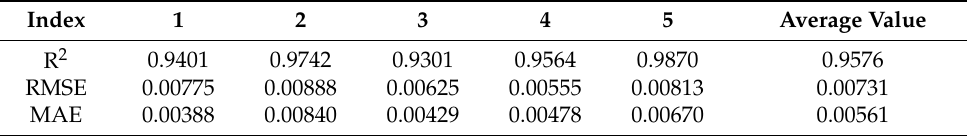
Table 7. Value of evaluation indices of the five-fold cross-validation for the RSM model on creep.